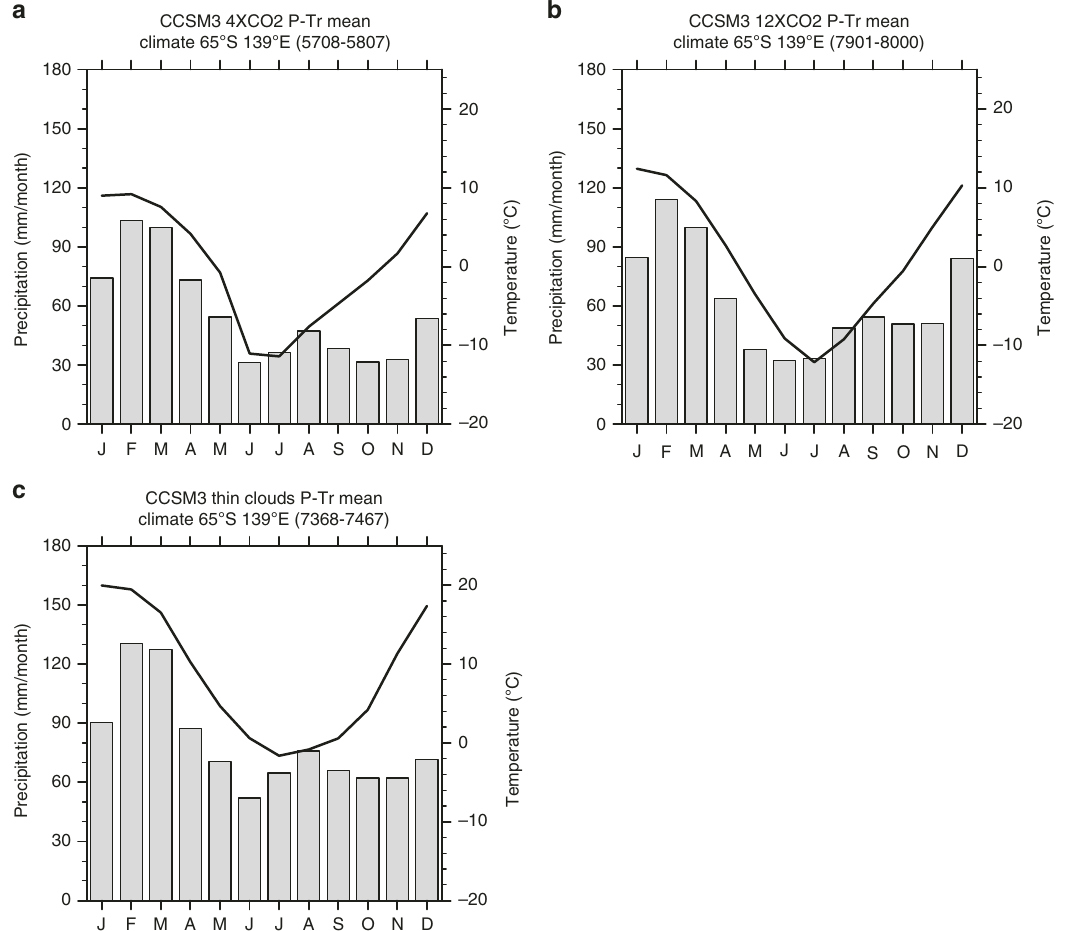
Fig. 4 Climatographs at the palaeo-location of the Sydney Basin. Based on simulations using the CCSM3 for the PTB 55 . a Simulation with 4× the pre- industrial CO 2 , level, b simulation with 12.7× the pre-industrial CO 2 level, and c simulation with 12.7× the pre-industrial CO 2 level and a lower cloud